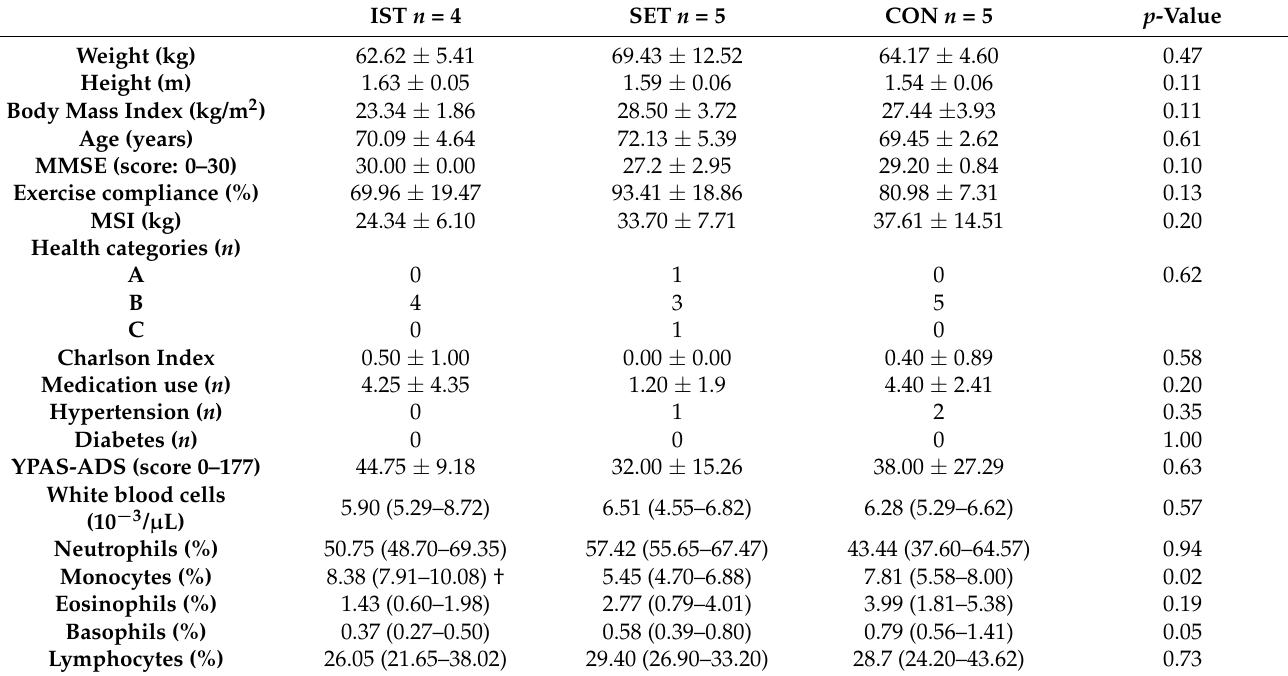
Table 1. Baseline characteristics from the included women in the RNAseq experiment.